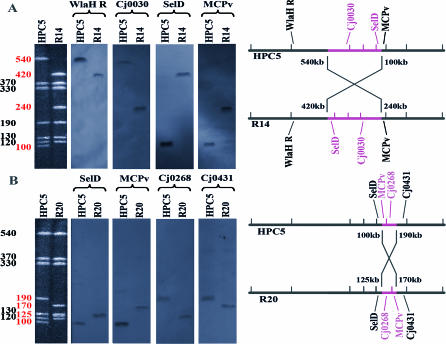
Rearrangements of C. jejuni upon Exposure to BacteriophagePFGE and Southern hybridisations of SmaI-digested C. jejuni genomic DNA from (A) HPC5 and bacteriophage-resistant derivative R14 and (B) HPC5 and bacteriophage-resistant derivative R20. The left-hand panels show SmaI fragments of genomic DNAs resolved by PFGE, and the adjacent panels show the corresponding Southern blots hybridised to the genes indicated above each panel. The sizes of the DNA bands resolved by PFGE in kbp are indicated to the left of the image with the invariant bands marked in black and those involved in the genome rearrangements marked in red. Hybridisations were performed using DIG-labelled probes synthesised by PCR. To the right of these are scale diagrams indicating the genome rearrangements from HPC5 to generate R14 and R20. SmaI sites are indicated as vertical lines. The locations of the genes used in the hybridisations are indicated. The genes that retain their relevant positions are marked in black, and those involved in the genome rearrangements are marked in red. Images of the hybridisations using genes adjacent to the other SmaI sites can be found in Figure S1.